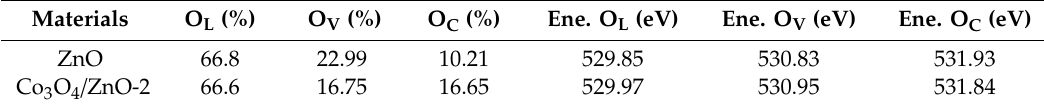
Table 1. Comparison of the states of O L , O V , and O C in ZnO and Co 3 O 4 / ZnO-2 (Ene. O L / O V / O C —the binding energy of O L / O V / O C ) (O L , O V , and O C are lattice oxygen, vacancy oxygen and chemisorbed oxygen, respectively).